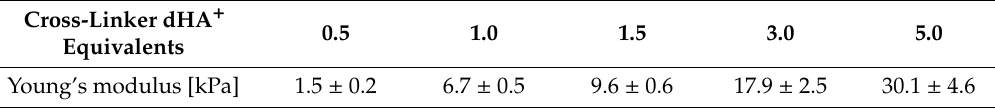
Table 1. Young’s modulus dependency of HA-DTPH 58% with varying dHA + equivalents . Cross-Linker dHA + Equivalents